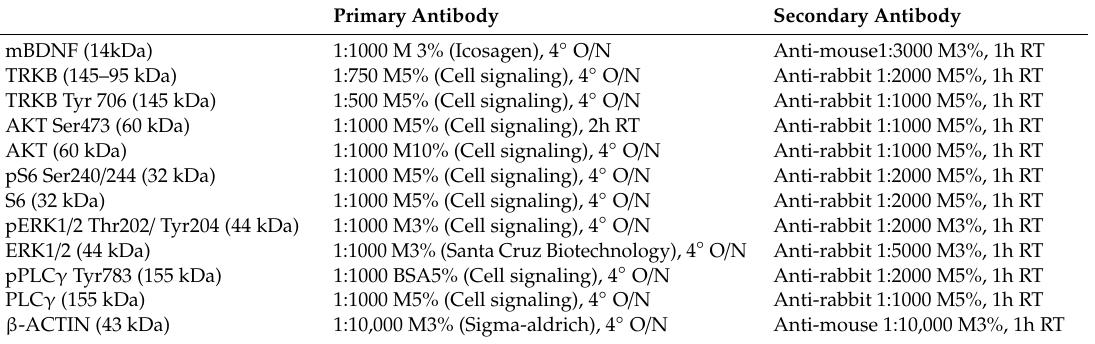
Table 3. Antibodies condition used in the Western blot. Milk: M, overnight: O / N, room temperature: RT, bovine serum albumin: